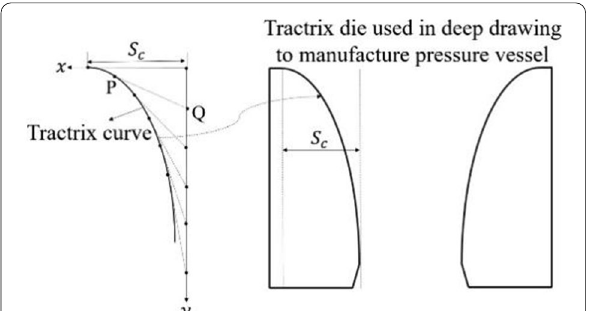
Figure 6 Definition of tractrix curve used in the 1 st deep drawing die